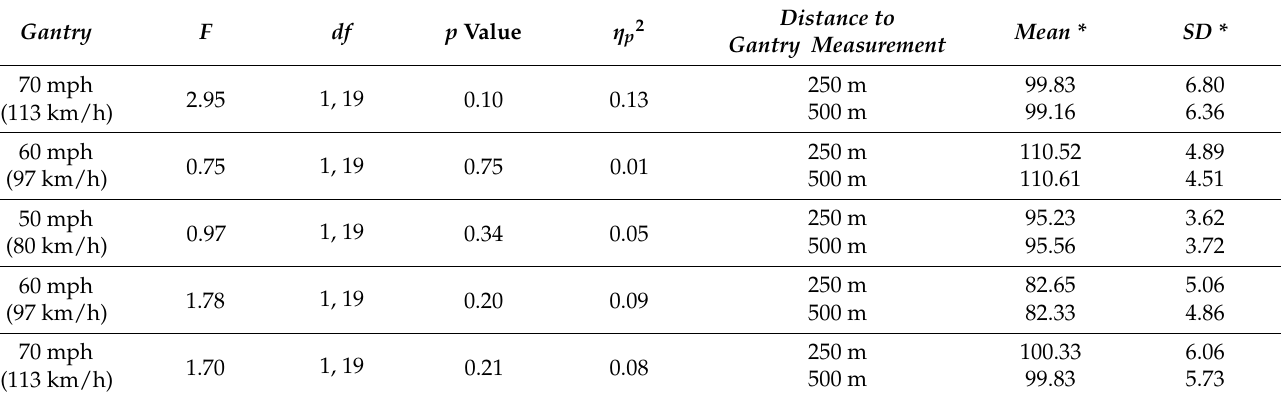
Table 2. Repeated measures ANOVA conducted to compare mean speeds within the baseline noHMI condition.